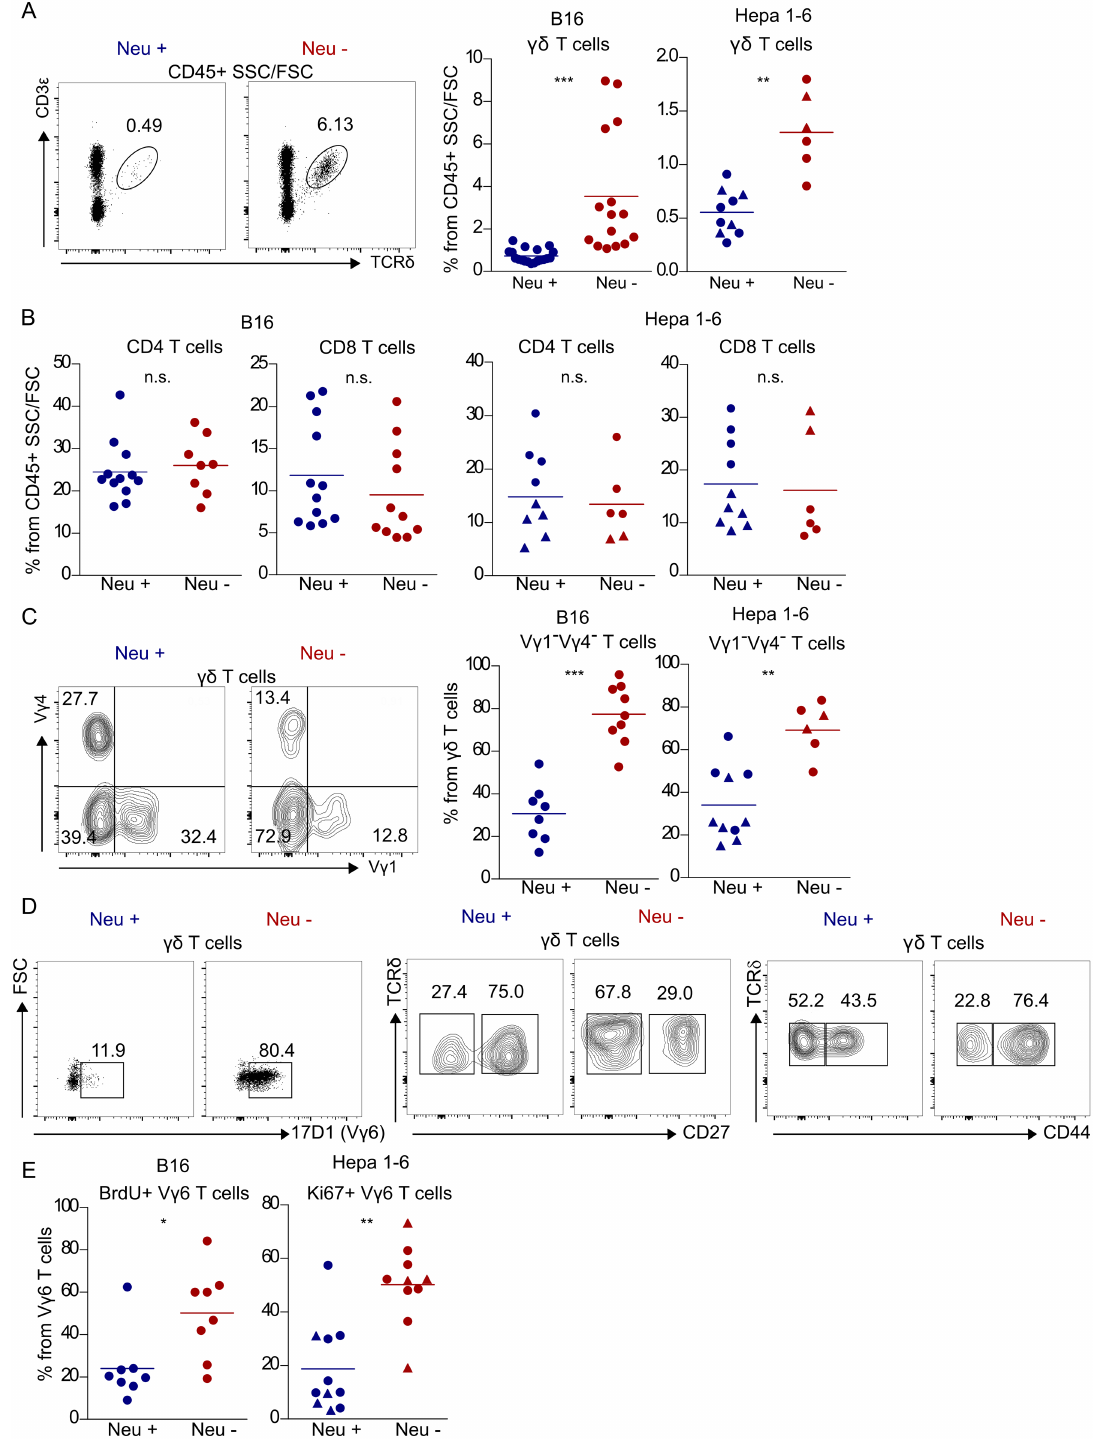
Fig 2. Neutrophils selectively inhibit the proliferation of V γ 6+ γδ T cells. Representative FACS plots and/or frequency (gated on CD45 + lymphocytes) of (A) γδ T cells, (B) CD4 + and CD8 + T cells, and (C) V γ 1 − V γ 4 − γδ T cells (gated on γδ T cells) in intraperitoneal B16 or intrahepatic Hepa 1–6 tumors, developed in mice deficient/depleted for neutrophils (Neu −) or respective controls (Neu +). Red and blue circles represent α Gr-1 mAb-treated or PBS-treated C57BL/6 mice, respectively, whereas red and blue triangles represent Genista homozygous or littermate controls, respectively. Data were pooled from two (Hepa 2–6) and three to five (B16) independent